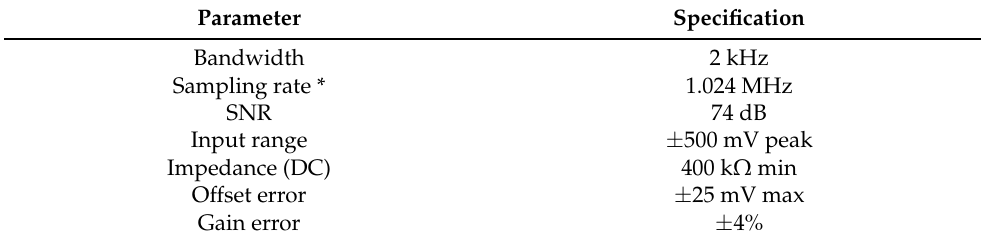
Table 3. ADE7878A 24-bit differential ADC’s specifications [37].